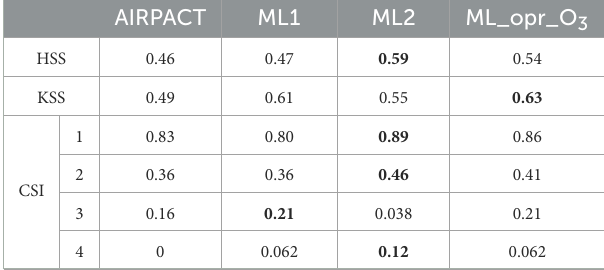
TABLE 3 Forecast verifications of the 10-time, 10-fold cross-validations using AQI computed with only O 3 from AIRPACT and our ML